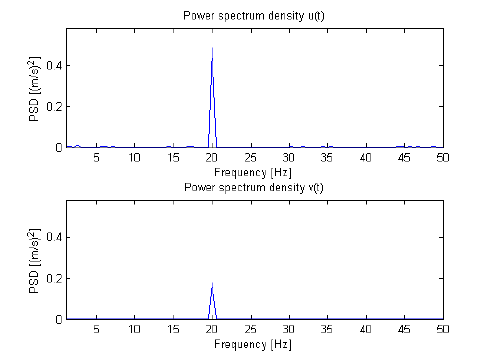
Fig. 10c. Phase angle ϕ=π . Frequency spectrum at point X for regime I.